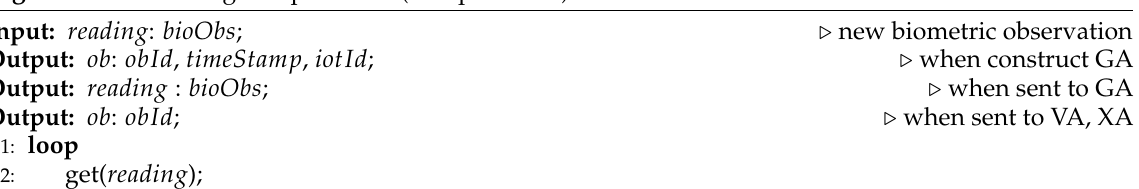
Algorithm 2 The IA agent operations